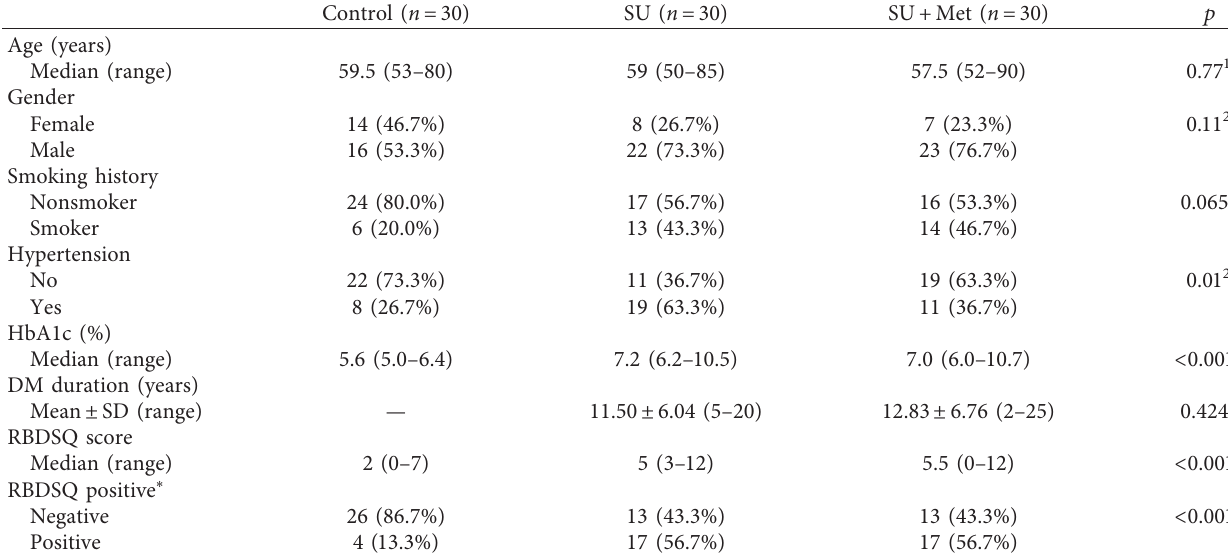
Table 1: Demographic data of the diabetic patients and controls.